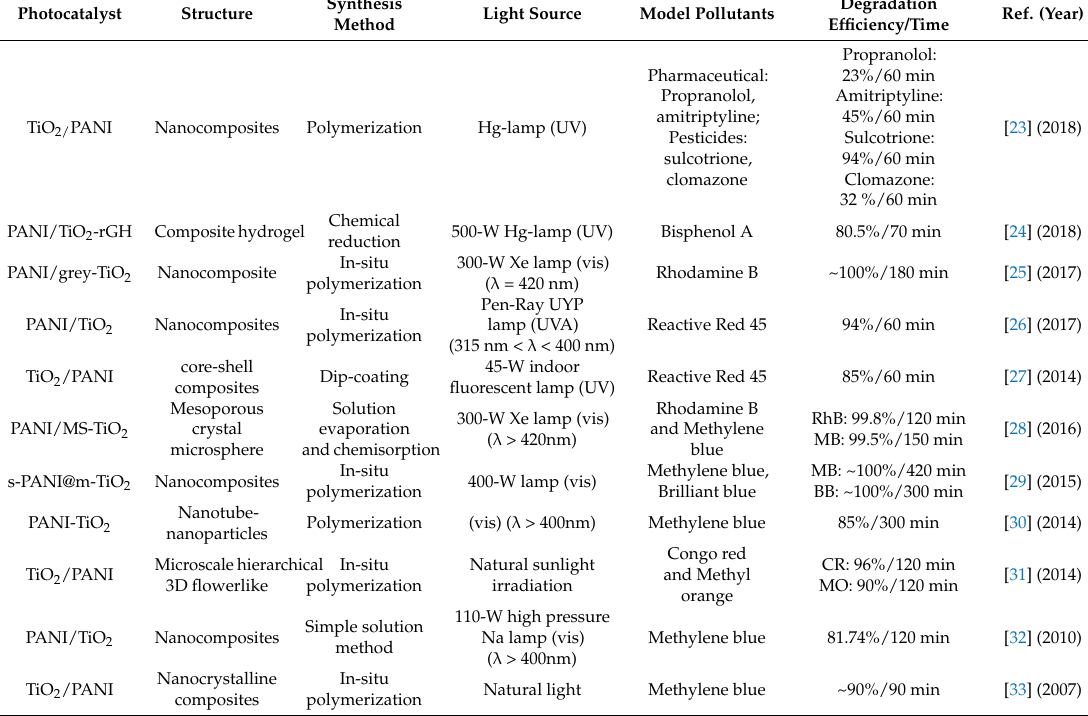
Table 2. Compositions, preparation methods, testing conditions, and photodegradation efficiency of PANI/TiO 2 composite